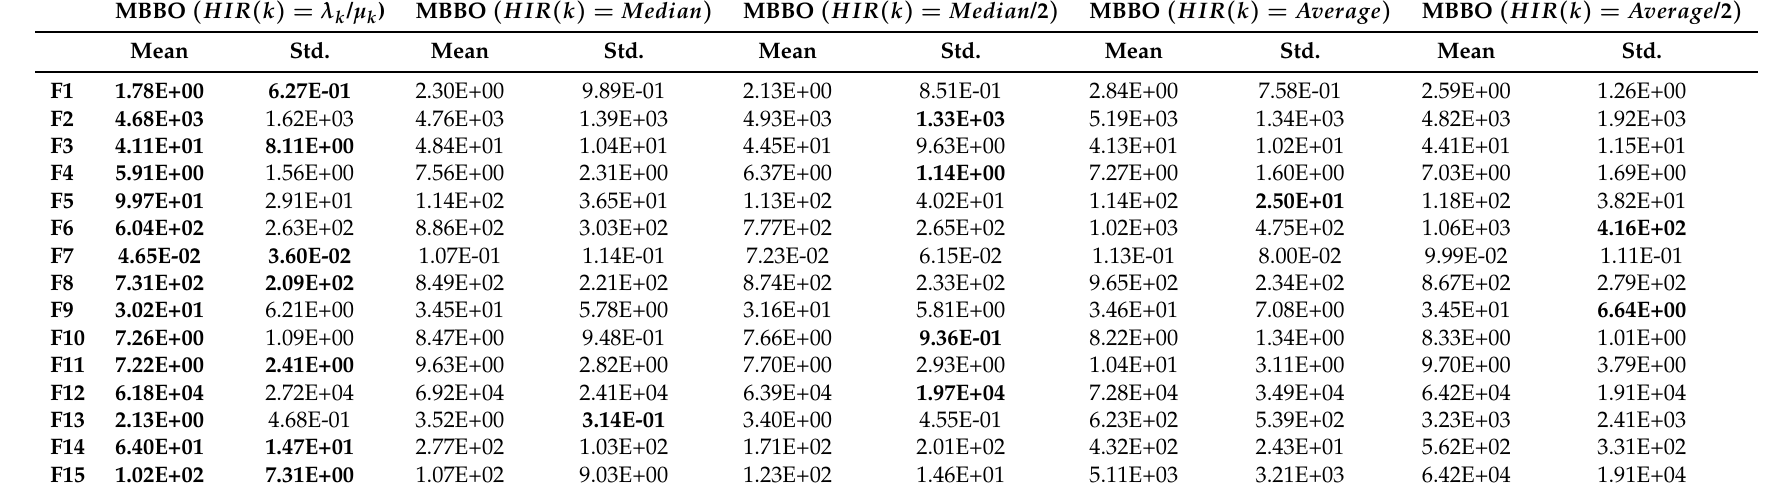
Table 4. Comparison of efficiency with different values of habitat immigration reference (HIR). Let the HIR value be the ratio between habitat immigration rate and emigration rate, the mid-value in habitat similarity matrix S , half of the mid-value of habitat similarity matrix S , the average of habitat similarity matrix S , and half of the average of habitat similarity matrix S . Then, compare the efficiency of algorithms with the averages and standard deviations in 25 independent tests using